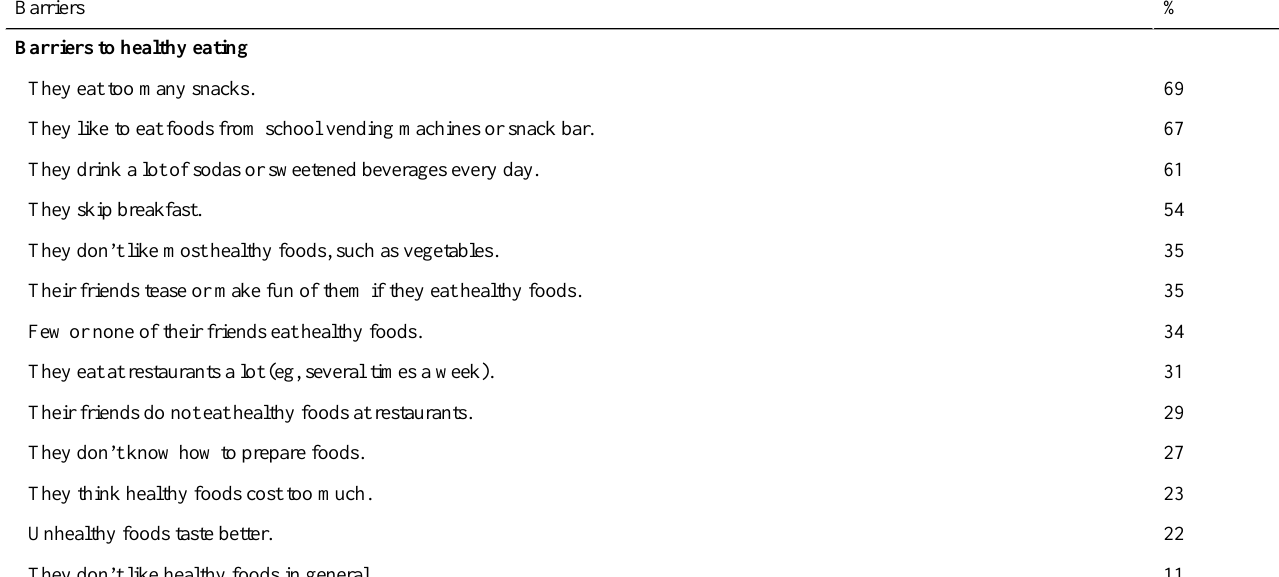
Table 1. Percentage of responses to commonly reported barriers to healthy eating [25-41] and obtaining physical activity [42-58] from adolescents attending initial focus